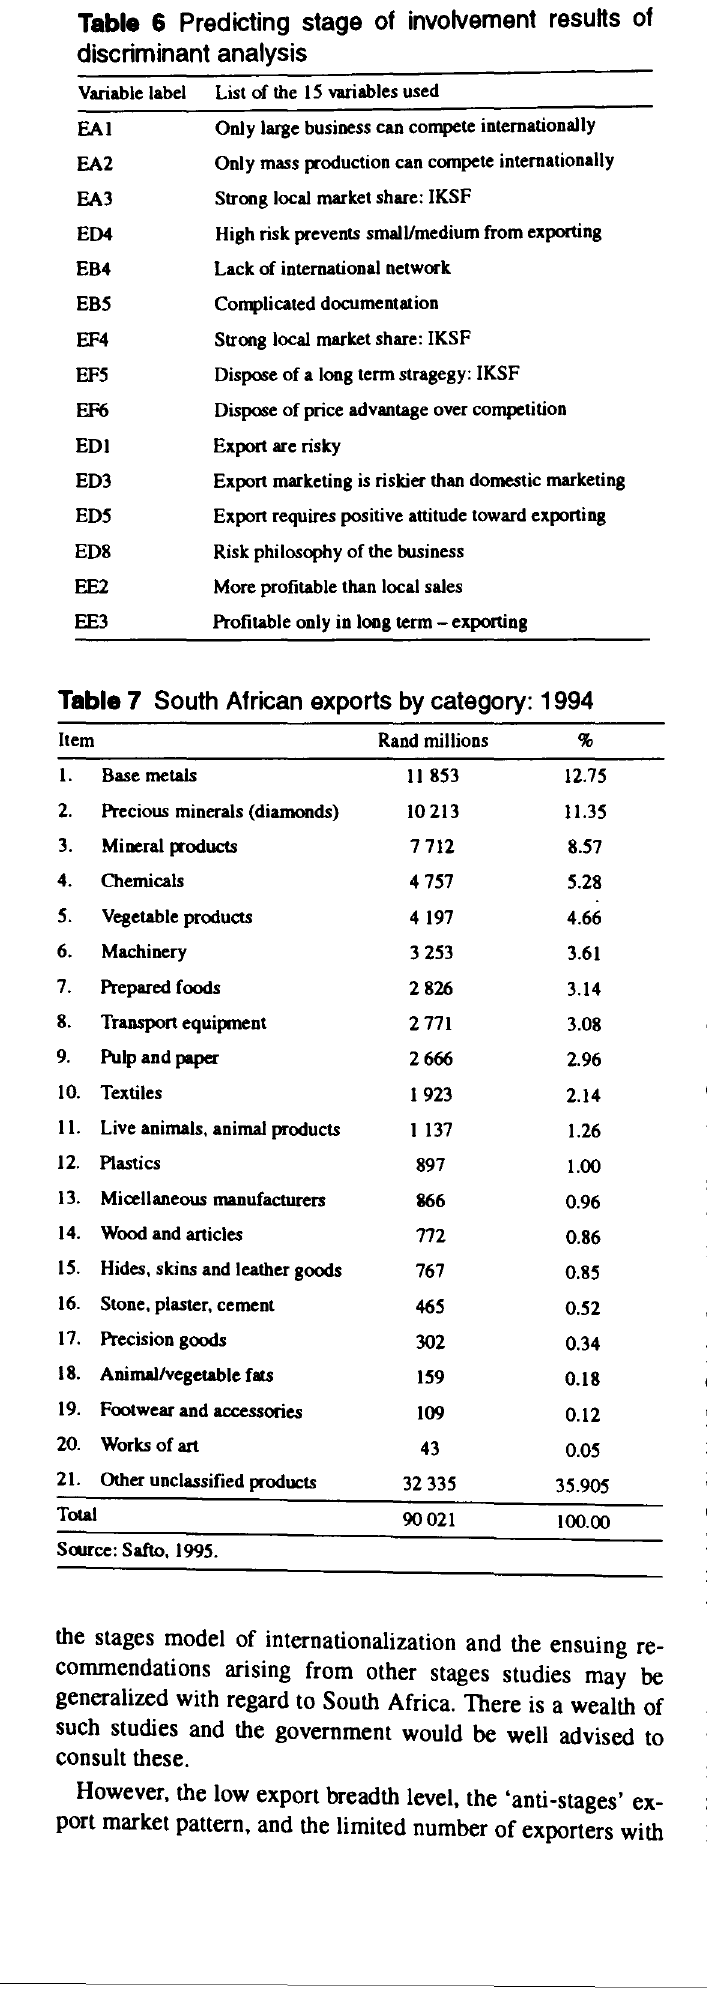
Table 6 Predicting stage of involvement results of discriminant analysis